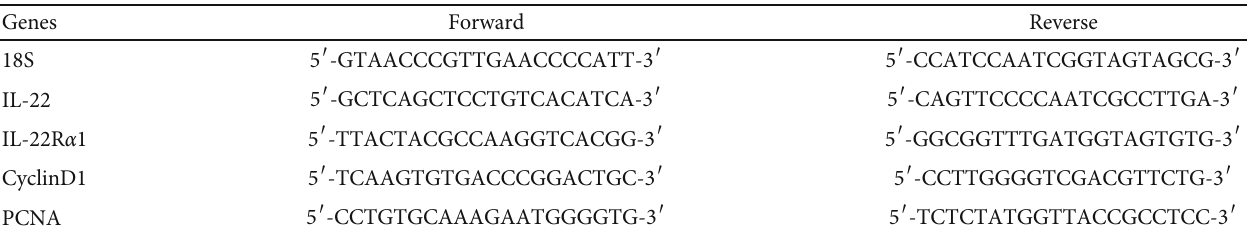
Figure 1: Schematic illustration of the experimental protocol. SHI: sham operation for hepatic ischemia-reperfusion injury; IRI-Sham: hepatic ischemia-reperfusion injury; IRI-Hv: hepatic ischemia-reperfusion injury + hepatic branch vagotomy; IRI-Hv-IL-22: hepatic ischemia-reperfusion injury + hepatic branch vagotomy + IL-22. Table 1: List of qPCR primer